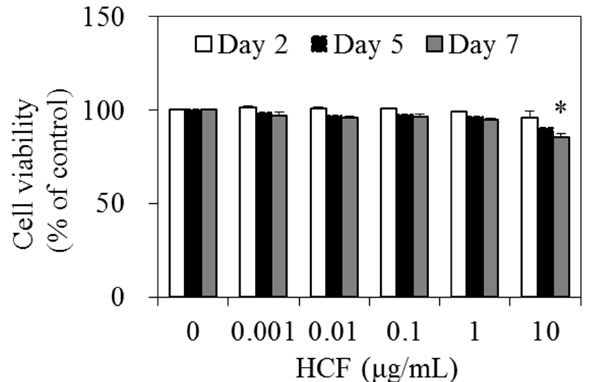
Figure 2. Effects of HCF on 3T3-L1 cell viability. Cell viability was determined using the water-soluble tetrazolium salt (WST)-8 assay. Cells were treated with 0 (control), 0.001, 0.01, 0.1, or 10 µg/mL HCF, and incubated for 2, 5, or 7 days. Values are expressed as a mean ± standard error of three independent experiments. * p < 0.05 vs. untreated control. HCF, hot water extract of C. morifolium flower.